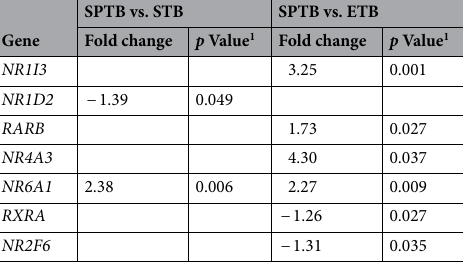
Table 3. Significant ( p < 0.05) differences in NR gene regulation among SPTB, STB, and ETB in placental transcriptomics data. 1 Nominal association.